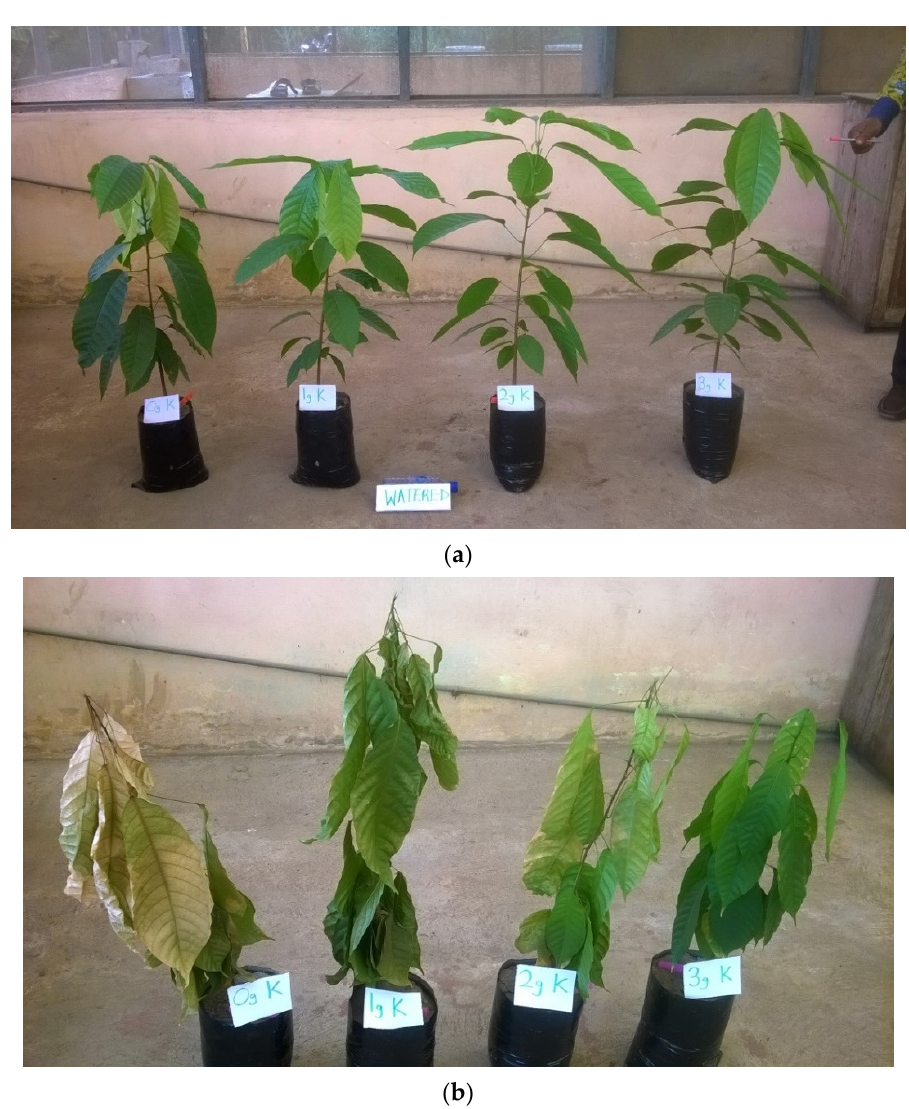
Figure 5. Effect of K on cocoa seedlings under ( a ) well-watered conditions and ( b ) water stress